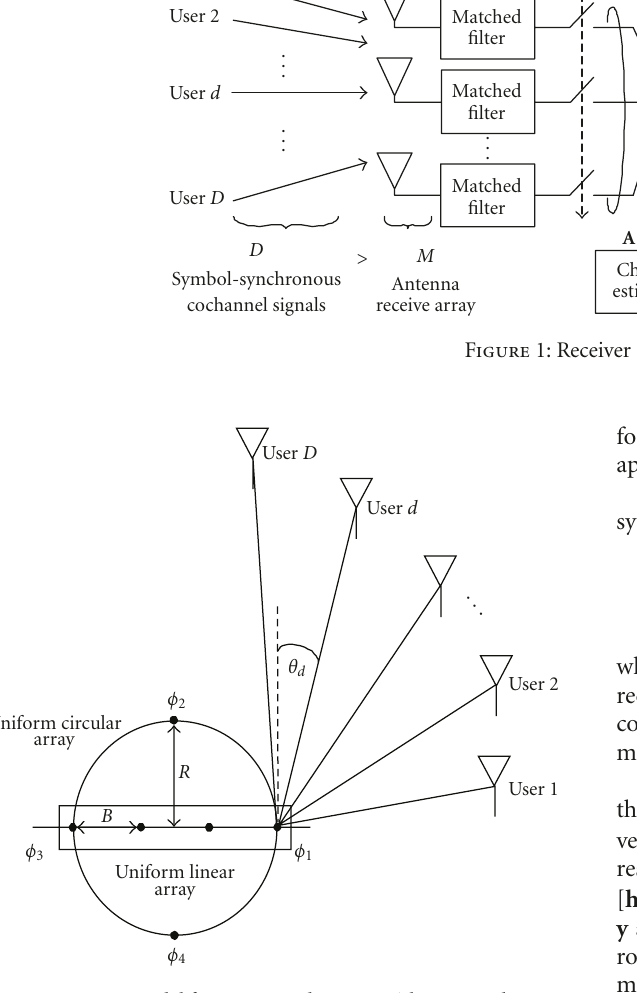
Figure 2: System model for a ULA and a UCA with M = 4-elements and D > M single-antenna